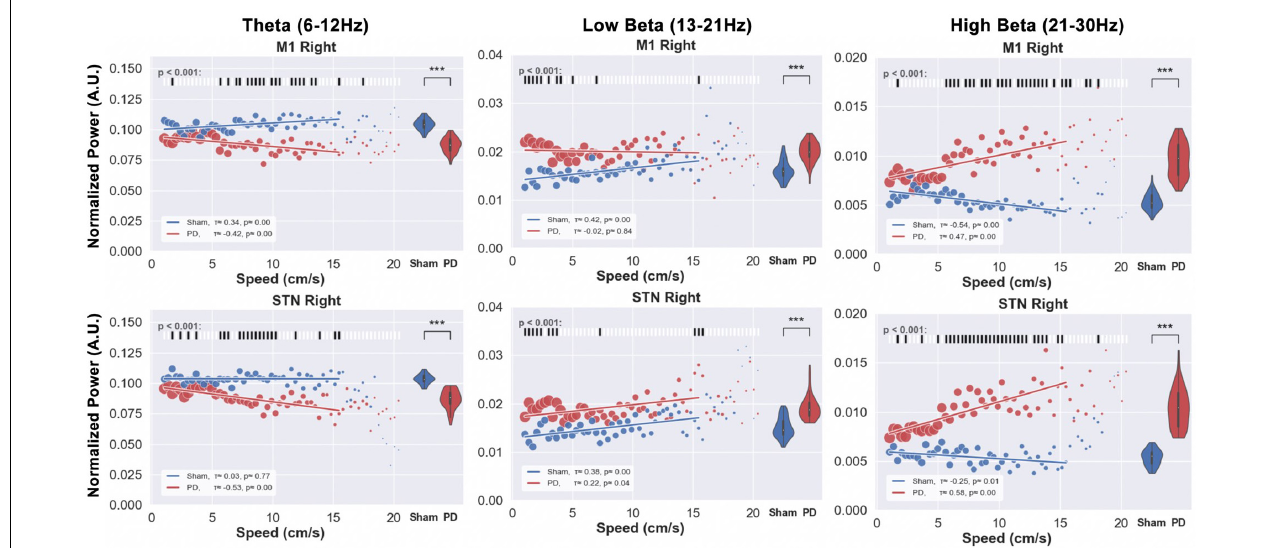
FIGURE 13 | The relation between speed and band power in forced movements on the rotarod was investigated for PD and sham rats. The speeds of the rotarod as well as the electrophysiological signals (M1 and STN) of the same time stamps were plotted for theta, low, and high beta bands. Each data point represents the median of the band power measured at each speed. The size of each point represents the relative amount of data per point. The distribution of the power, over all the speeds is represented by the violin plots on the right side of each subfigure, and the results from the significance test of the difference between the PD and sham band power, at each speed are illustrated in the raster plots above the figures. The theta power, measured from both the right STN and M1 regions over all the speeds (1 ˝U16 cm/s) are significantly lower in PD rats compared to the sham group, while both low and high beta power showed higher values for PD compared to sham rats. Unlike the results from the OF test, the results from the STN are in line with the results from M1. Additionally, the low beta band shows stronger significant differences between PD and sham speed-power pairs only at lower speeds (<4 cm/s) while theta and high beta bands exhibit significant differences at higher speeds (>4 cm/s). Level of significance: (*** p < 0.001). Figure adapted from Mottaghi